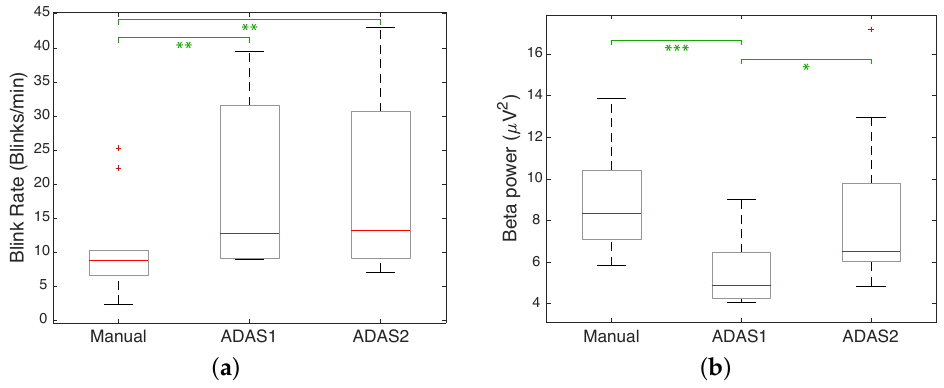
Figure 9. ( a ) Box plot of EBR in Manual, ADAS1, and ADAS2 scenarios; ( b ) box plot of beta power in Manual, ADAS1, and ADAS2 scenarios. The red lines correspond to the medians, the boxes correspond to the first and third quartiles, the whiskers correspond to the values based on the Interquartile Range (IQR) computation, and the red plus sign markers correspond to the outliers. The green asterisks refer to the p -values computed using t -tests.